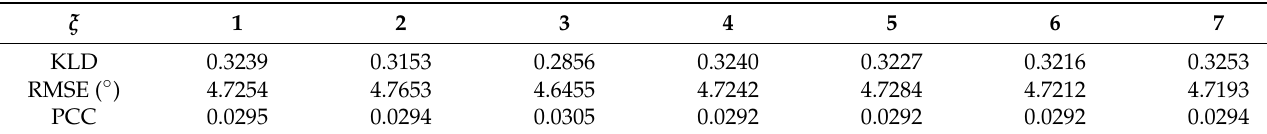
Figure 10. Wind direction sequence obtained by FC-GLCM algorithm when parameter σ is di ff er- ent. (The pink curve with the open points represents the wind direction measured by the vane ane- mometer.)